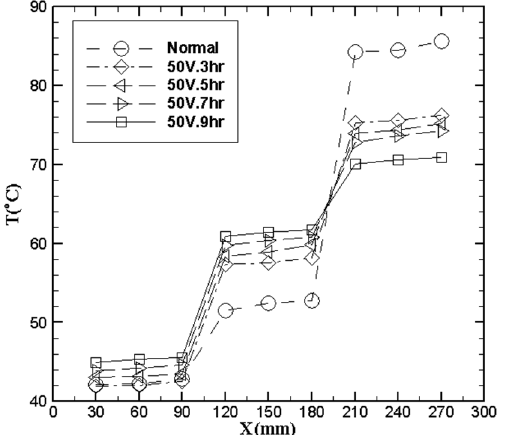
Figure 5. Temperature distributions under an input heat power of 100 W for different treatment times at an anodizing voltages of 50 V.